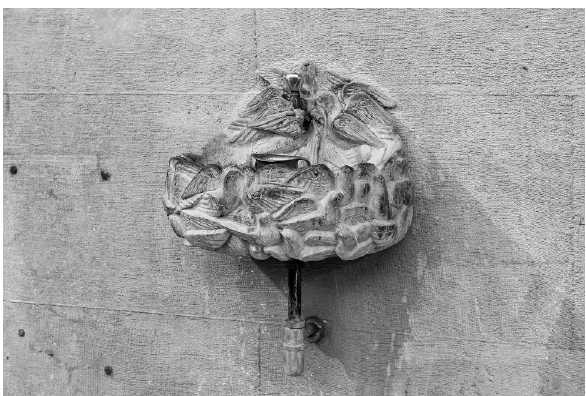
Figure 5. Artworks in the courtyard: Ruth Zarfati and Moshe Sternschuss, a bronze basin, ca. 1968. Photo: Eli Singalovski, 2018. Used with permission .